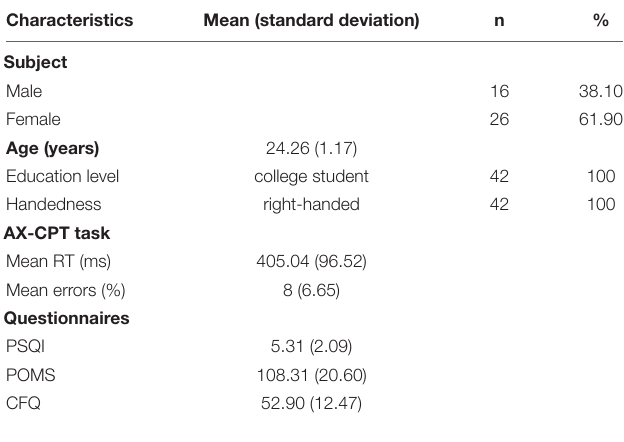
TABLE 1 | Mean task results of all